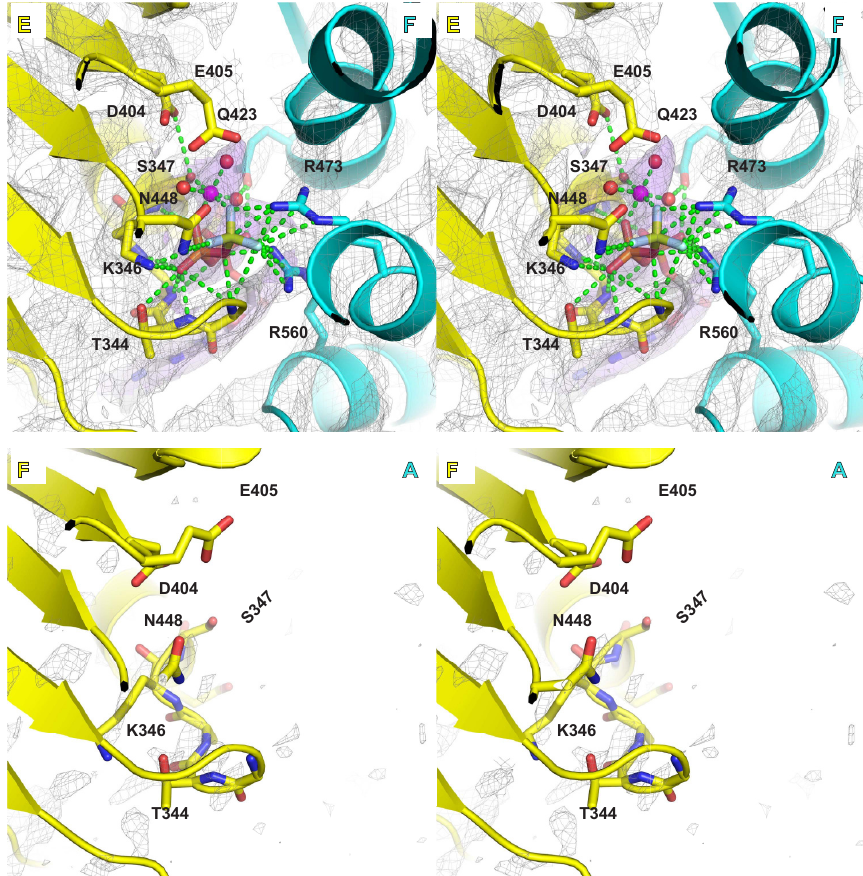
Figure 5. Stereoviews of the six subunit interfaces of class 2 illustrating the Mg/ATPase sites. The specific subunits comprising the interfaces are indicated by their chain identifiers (A,B,C,D,E,F). The illustrated maps and models were obtained by refinement of the merged particles of class 2 obtained for three different oligonucleotides (see Figures S10B, S11B and S12B). For each view, the subunit containing the Walker-A and -B residues is depicted in yellow, and the neighboring subunit with the arginine finger is depicted in cyan. Density above 5.0-sigma is shown in grey mesh with density